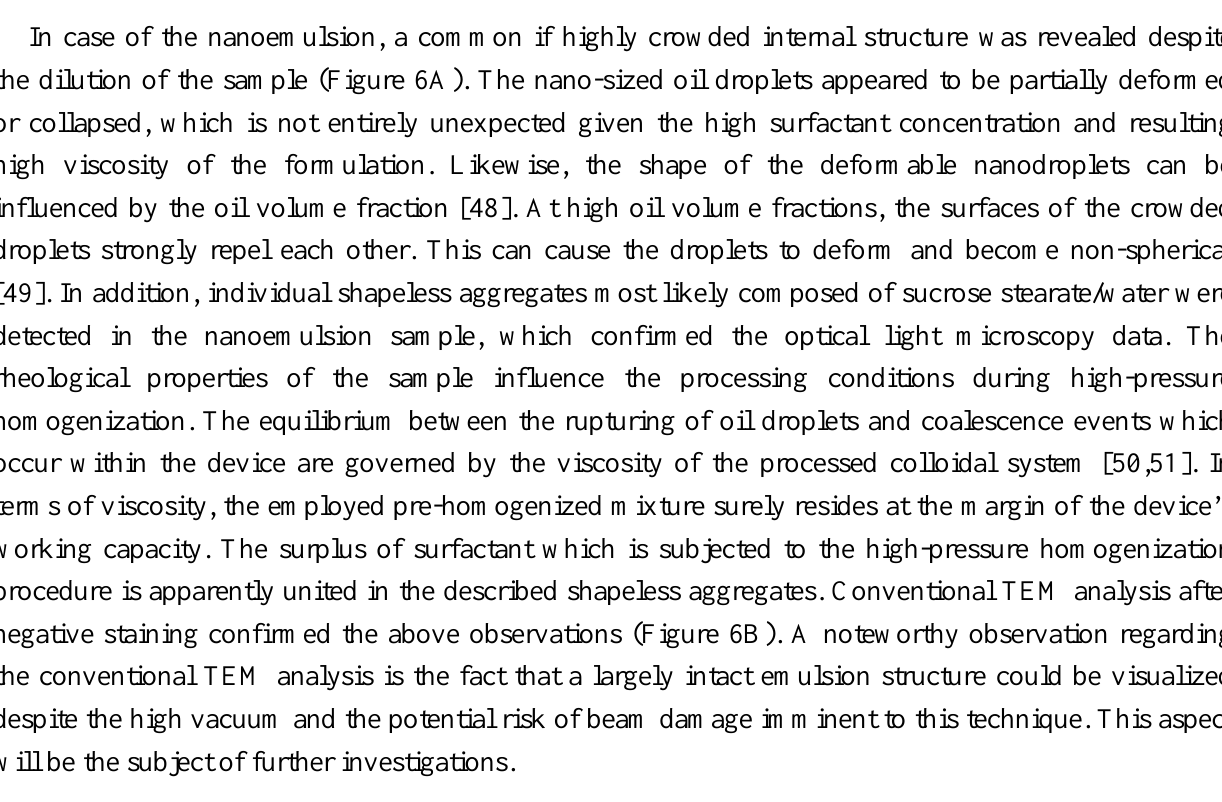
Figure 6. Analysis of the microstructure of blank nanoemulsions by cryo TEM (6A) and conventional TEM after negative staining with uranyl acetate (6B) . The magnification is illustrated by the black scale